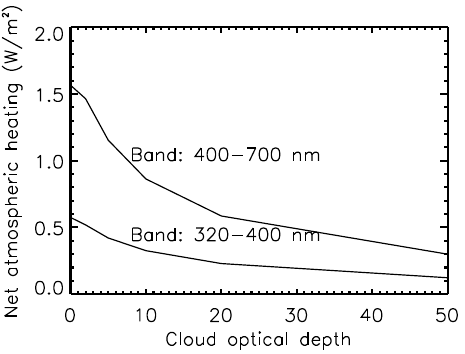
Fig. 4. NO 2 net atmospheric heating dependence on cloud optical depth, τ , when the NO 2 layer is below the cloud.